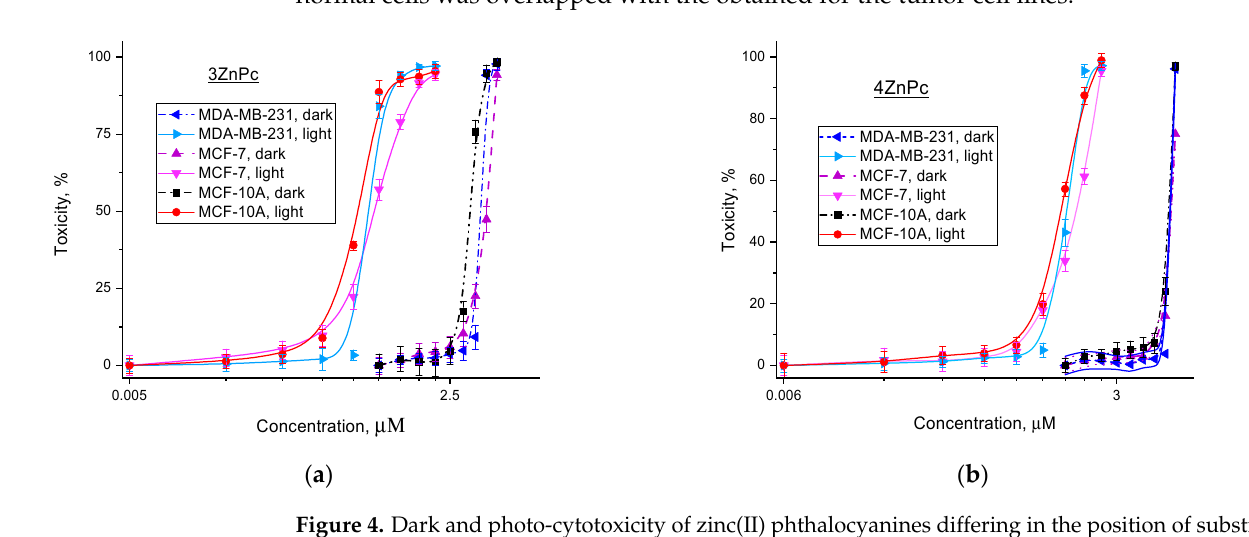
Figure 3. Dark and photo-cytotoxicity curves of cobalamin (Cbl) studied on: ( a ) normal BALB 3T3 cell line and non-tumorigenic MCF-10A cell lines; and ( b ) MCF-7 and MDA-MB-231 tumor cell lines. biologically active compound, such as Cbl, increased the photodynamic effect (PI) of 3ZnPc Non-peripherally substituted 3ZnPc was evaluated as a more powerful photosensi- for lower concentrations. Moreover, the highest efficiency of the combined application tizer in comparison to peripherally substituted 4ZnPc for the tested tumor cell lines. The of compounds Cbl and 3ZnPc was observed for the more aggressive MDA-MB-231 cells presented curves for 3ZnPc on tumor cell and the non-tumorigenic cells showed а con- (PI = 500). In addition, the mixture of 3ZnPc + Cbl was shown to lead to a high selectivity centration gap between the samples with and without irradiation for both of the tested of the photocytotoxicity tumor vs. normal cells (SI = 2.31). The results of Cbl to 4ZnPc ZnPcs (Figure 4). suggested that Cbl was not advanced by the cytotoxicity; moreover, the phototoxicity on normal cells was overlapped with the obtained for the tumor cell lines.